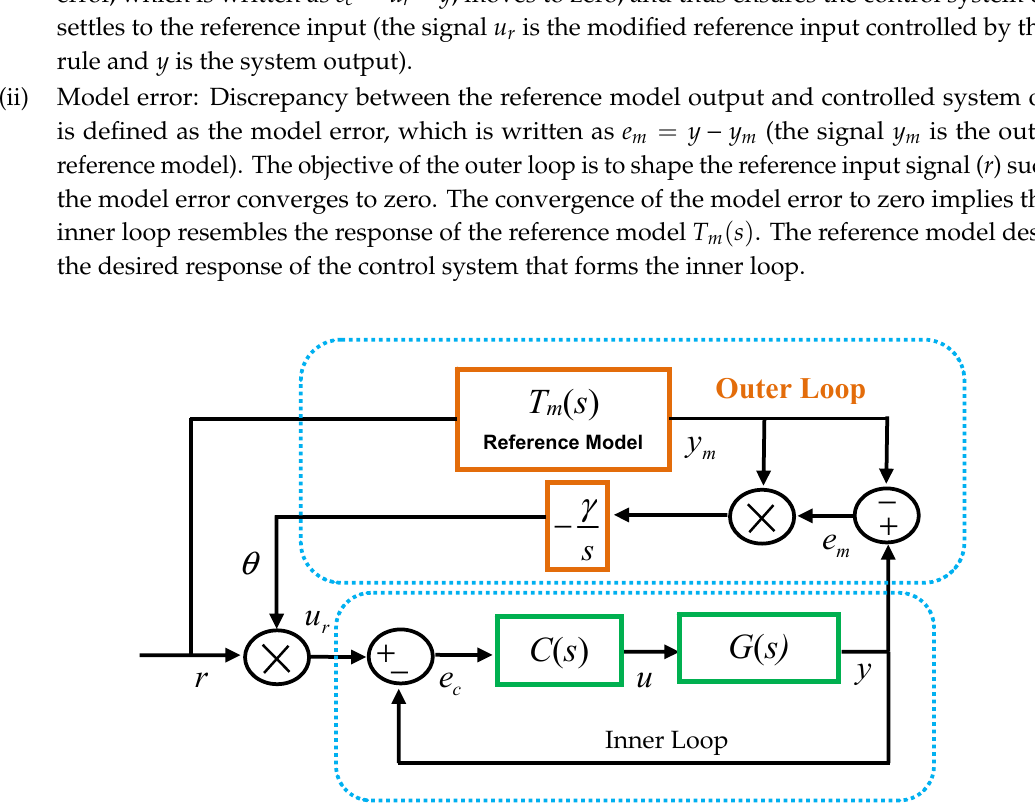
Figure 1. Block diagram of multi-loop model reference PID-MIT (ML-MR PID-MIT) control structure with input shaping.